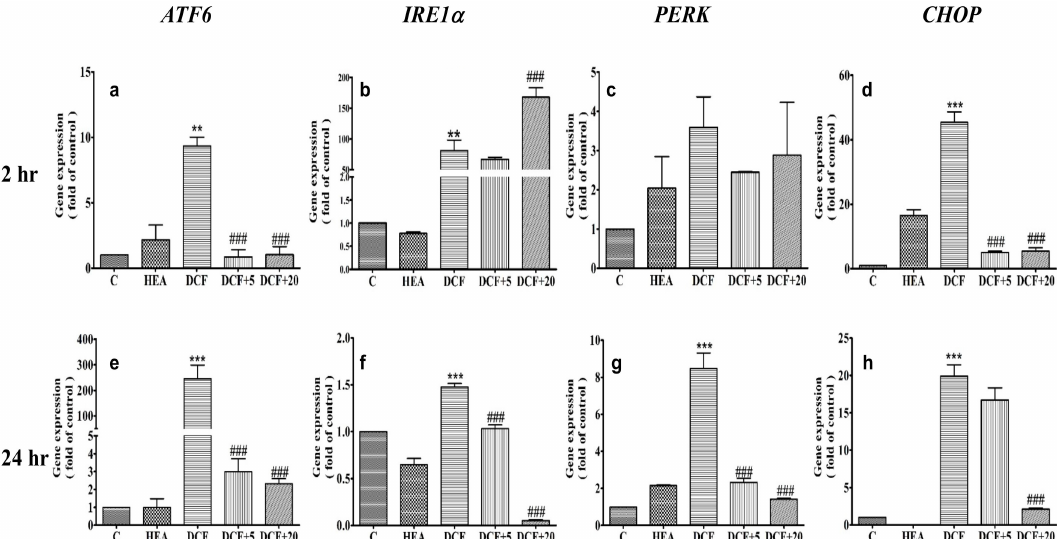
Figure 5. Effect of HEA on gene expression levels in HK–2 cells exposed to DCF. Cells were pretreated with HEA (20 µ M) and then exposed to DCF for 2 and 24 h. C: Control. HEA: HEA 20 µ M. DCF: DCF 200 µ M, DCF + 5: DCF + HEA 5 µ M. DCF + 20: DCF + HEA 20 µ M). Data are presented as mean ± SD from three independent experiments (** p < 0.01 and *** p < 0.001 versus the control group, respectively; ### p < 0.001 versus the DCF group. Upper panels ( a – d ) and lower panels